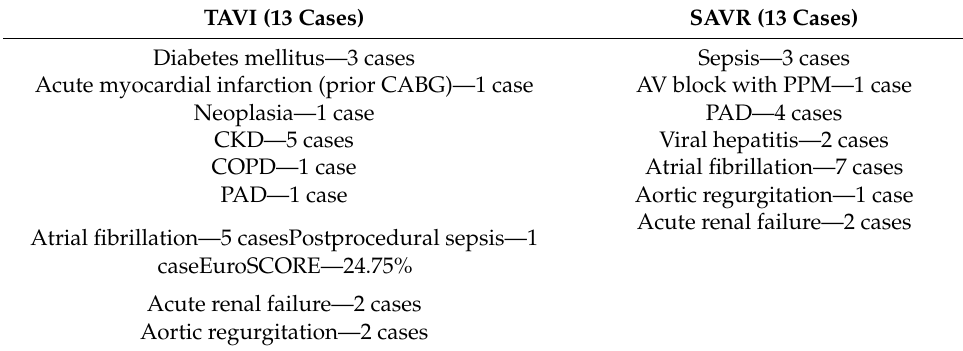
Table 5. Mid-term